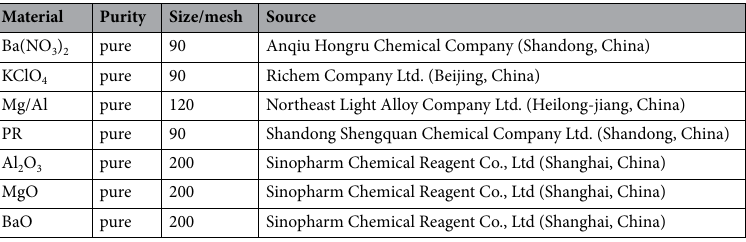
Table 1. The purity, particle size and source of the materials.